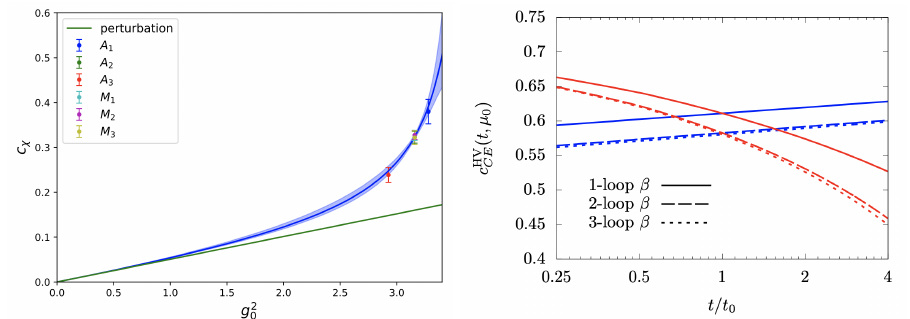
Figure 3. Left plot: bare coupling dependence of c χ = tc P ( t ,µ ) / Z χ . Lattice data with di ff erent colors (see Ref. [50]) are described with a Pade’ approximant constraint using our perturbative result [55]. Right plot: scale dependence of the qCEDM matching coe ffi cient. See main text and Ref. [51] for details on the